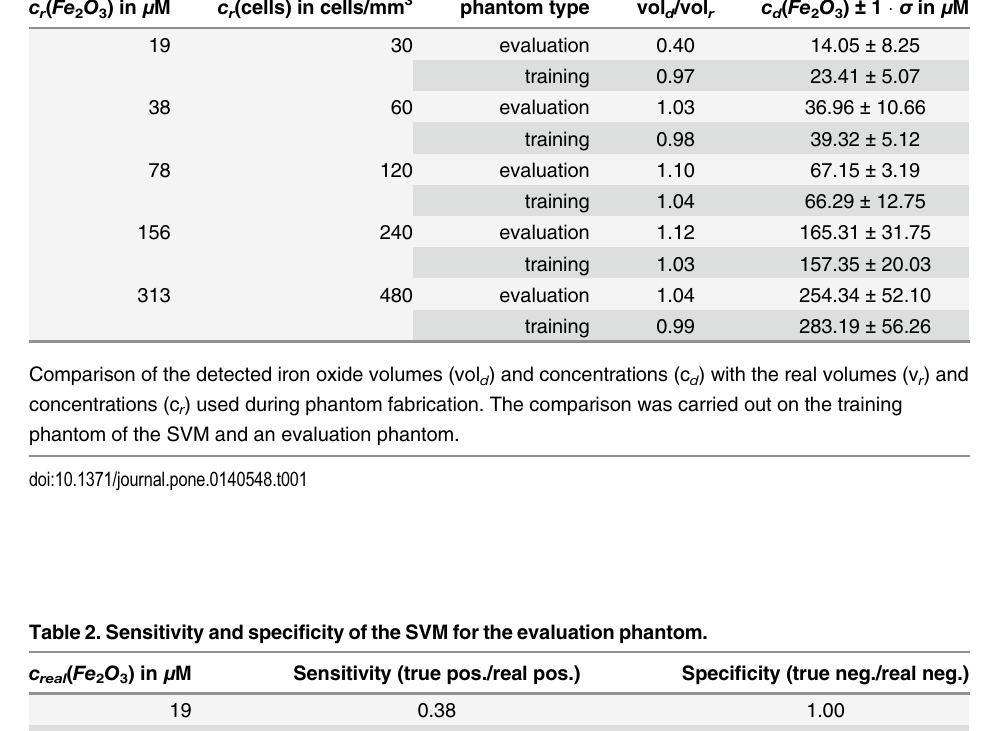
Table 2. Sensitivity and specificity of the SVM for the evaluation phantom. Fe O μ M Sensitivity (true pos./real pos.) Speci fi city (true neg./real neg.) c real ( 2 3 ) in 19 0.38 1.00 38 0.88 0.95 78 0.95 0.95 156 0.96 0.98 313 0.99 0.85 Sensitivity and speci fi city of the SVM for the evaluation phantom. Sensitivity was calculated by dividing the number of true positives by the number of real positives. Speci fi city was calculated by dividing the number of true negatives by the number of real negatives. The sensitivity increased with the concentration of labeled cells in agarose gel. The speci fi city decreased with increasing concentration of labeled